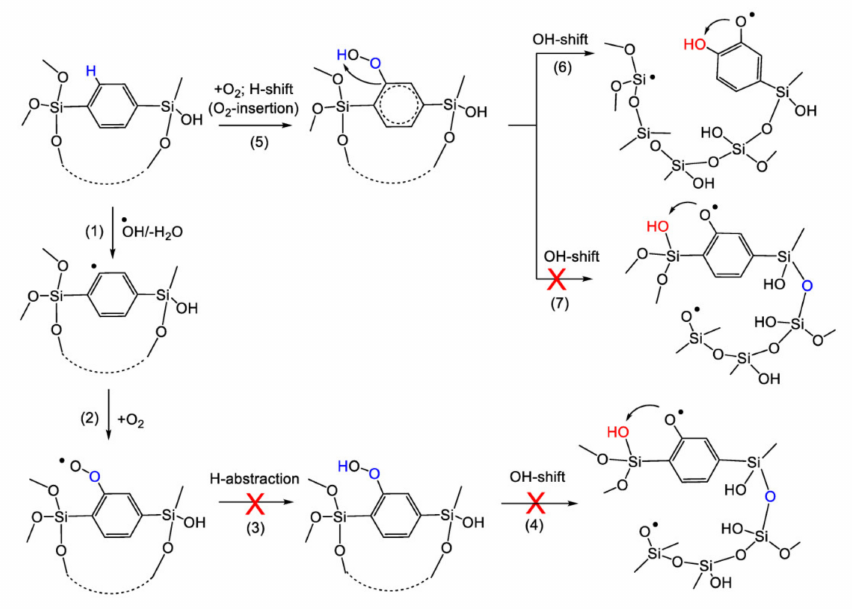
Figure 15. Calculated energetically favourable possible reaction pathways which could lead to bond scission in model polymers with the –Si–1,4-Ar–Si– bridge. Structures of model polymers are simplified for clarity. Reaction parameters ∆ H and ∆ G are given in Table